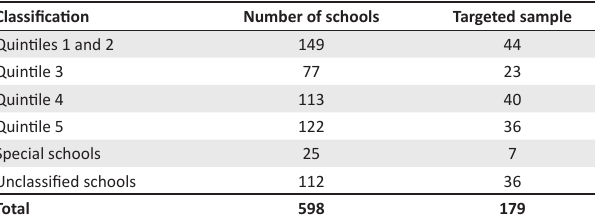
TABLE 1: City of Tshwane school categories indicating population and targeted